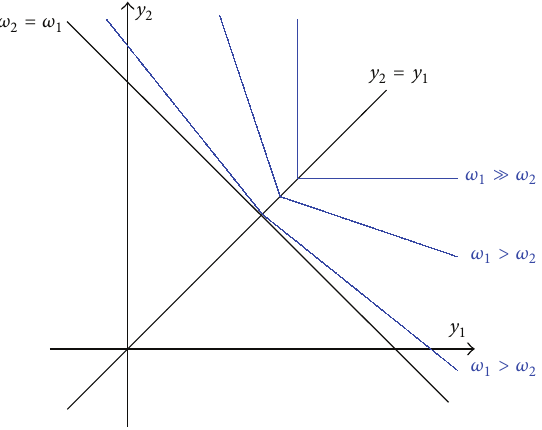
Figure 3: Variety of fair OWA